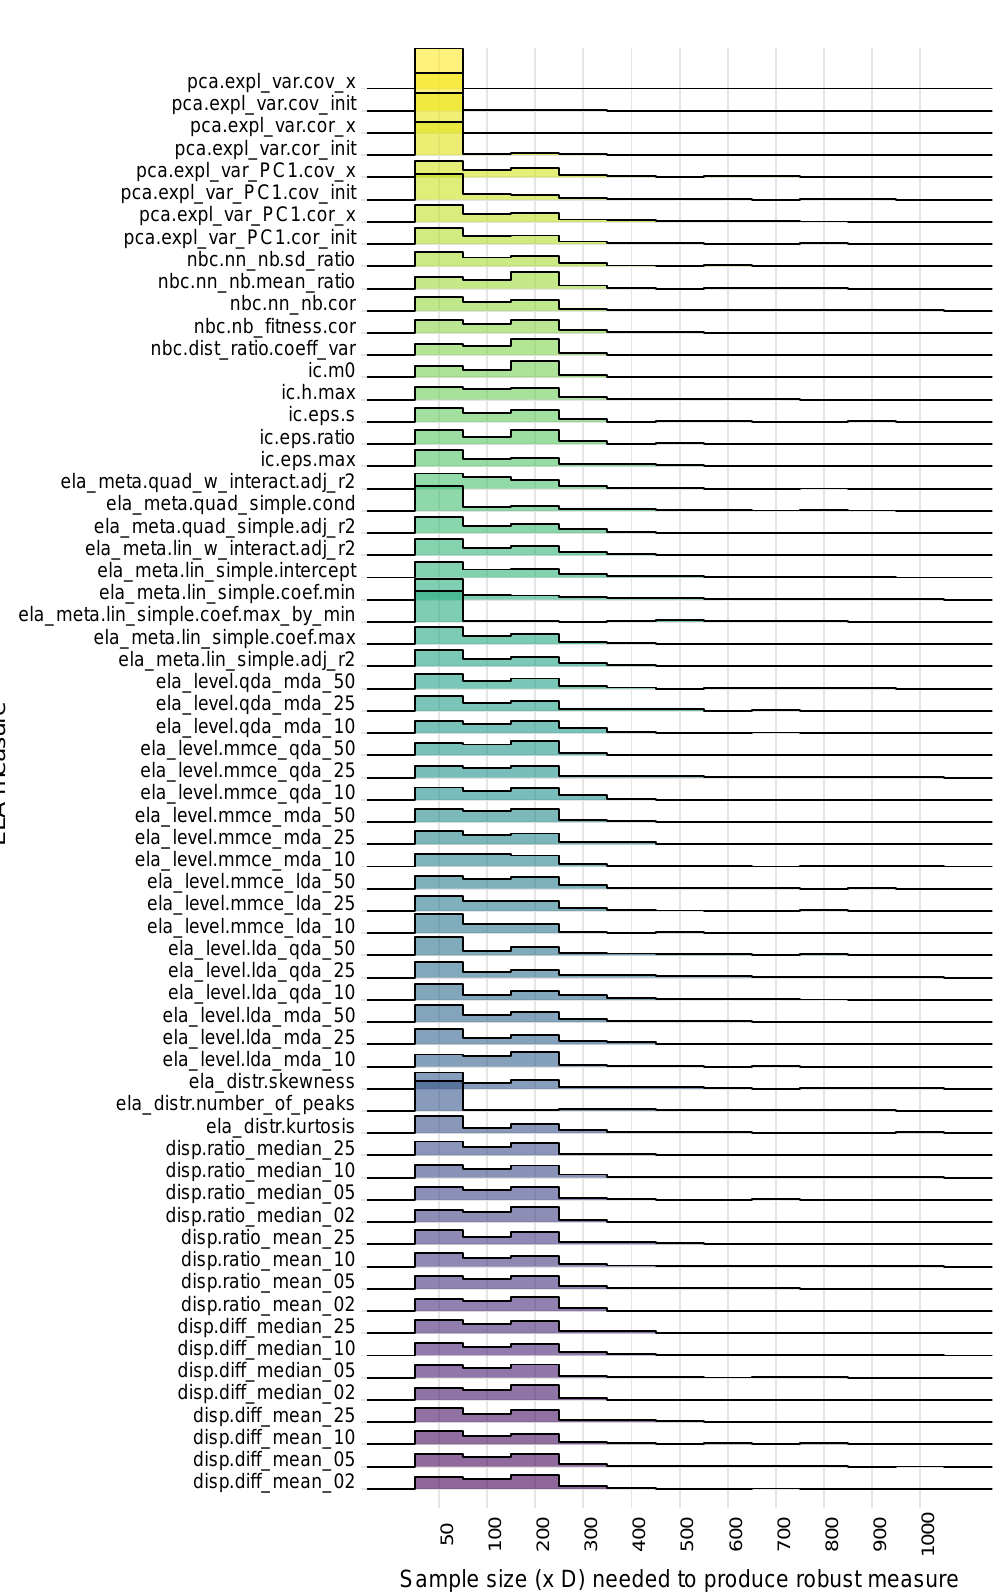
Figure 1. Distribution of the point of robustness for each of the investigated ELA measures across all benchmark functions in D = 10